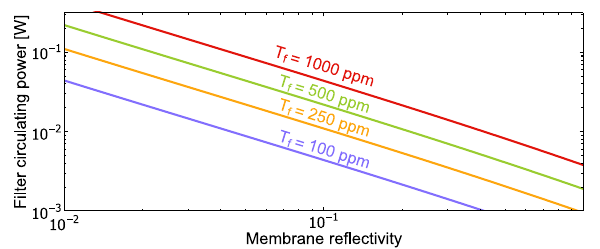
Fig. 2 Intracavity power for negative dispersion fi ltering using phononic crystal resonator. We wish to obtain optomechanical anti-damping γ π ) = 12 kHz using a phononic crystal membrane in a membrane-in- opt /(2 the-middle con fi guration. The required intracavity power is plotted versus the membrane power re fl ectivity for different input coupler transmissivities T f